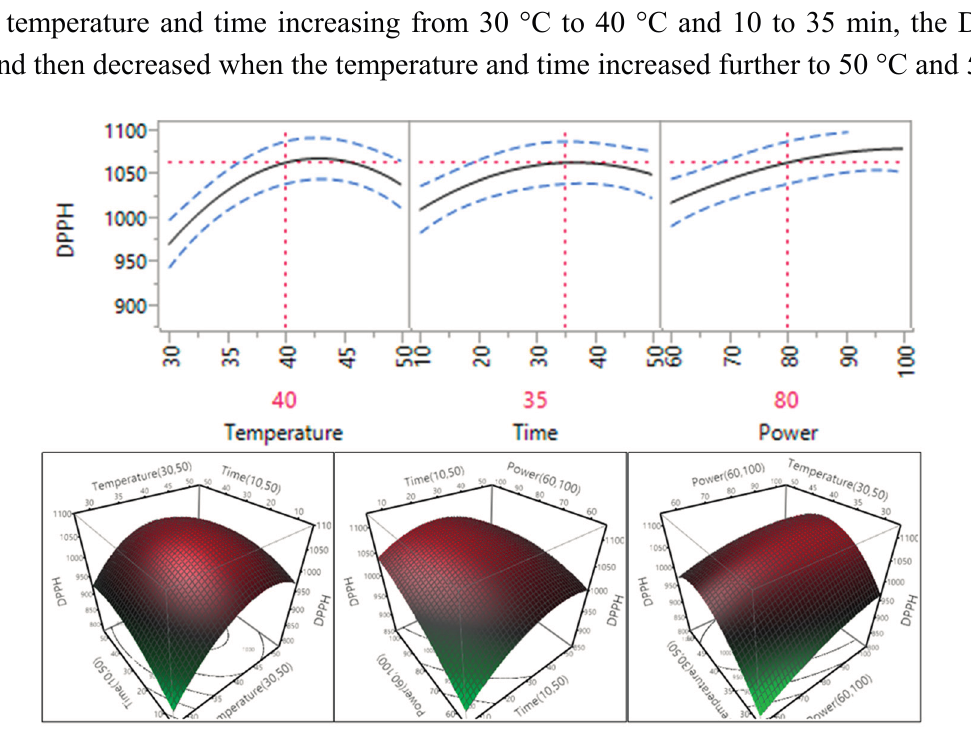
Figure 8. Impact of temperature (60–90 °C), time (10–30 min) and power (60%–100%) on DPPH free radical scavenging